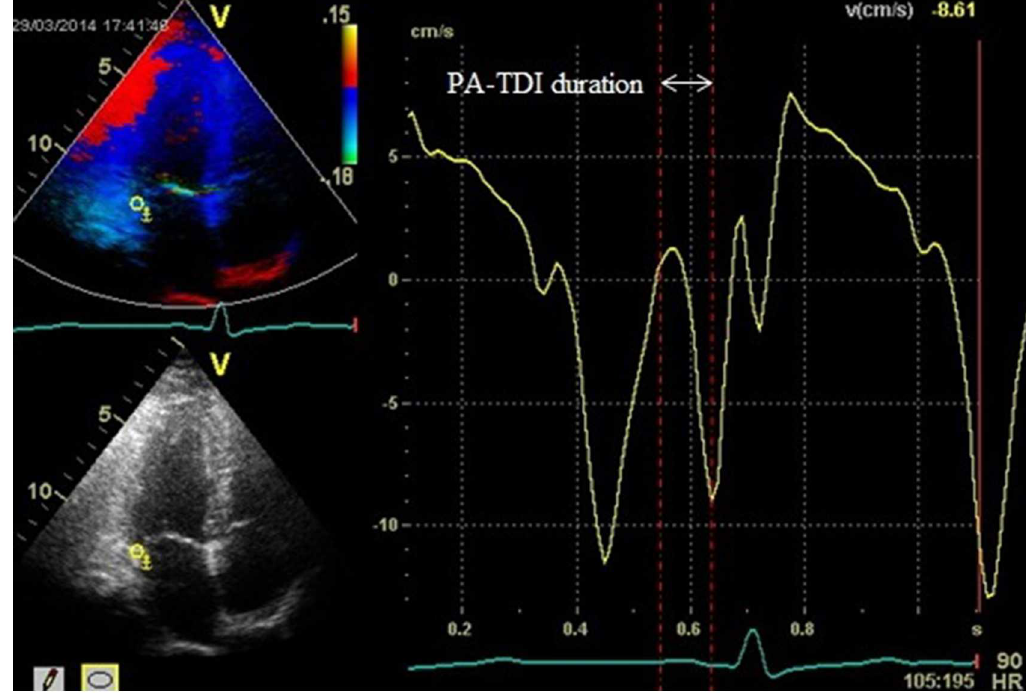
Figure 1 - Measurement of the total atrial conduction time (PA-TDI interval). The PA-TDI interval was defined as the time interval between the onset of the P-wave on the surface ECG and the peak Am wave on the tissue Doppler tracing. ECG: electrocardiogram; Am: tissue Doppler mitral annular late diastolic velocity.